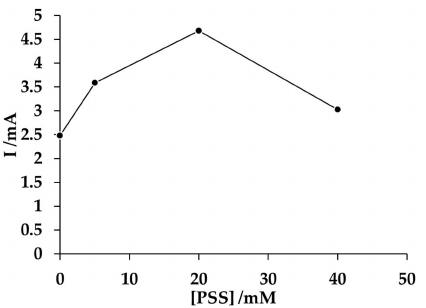
Figure 11. Plot of the anodic current peak (peak I, see Figure 10) as a function of the polyelectrolyte concentration in solution during the membrane modification processes.